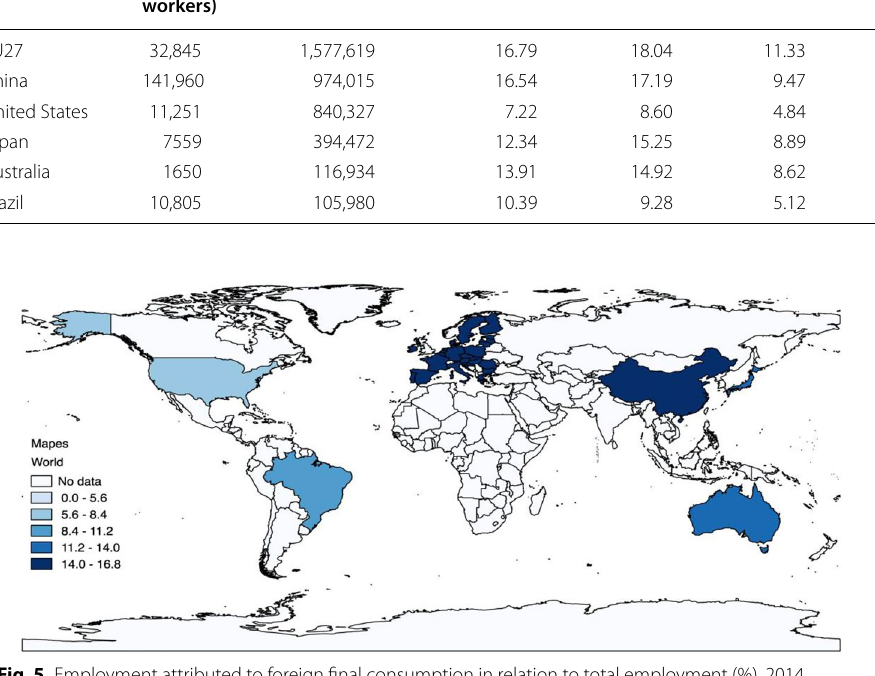
Table 4 Employment impact of foreign final consumption, 2014. Source: Author’s calculations based on the WIOD EXC (thousand